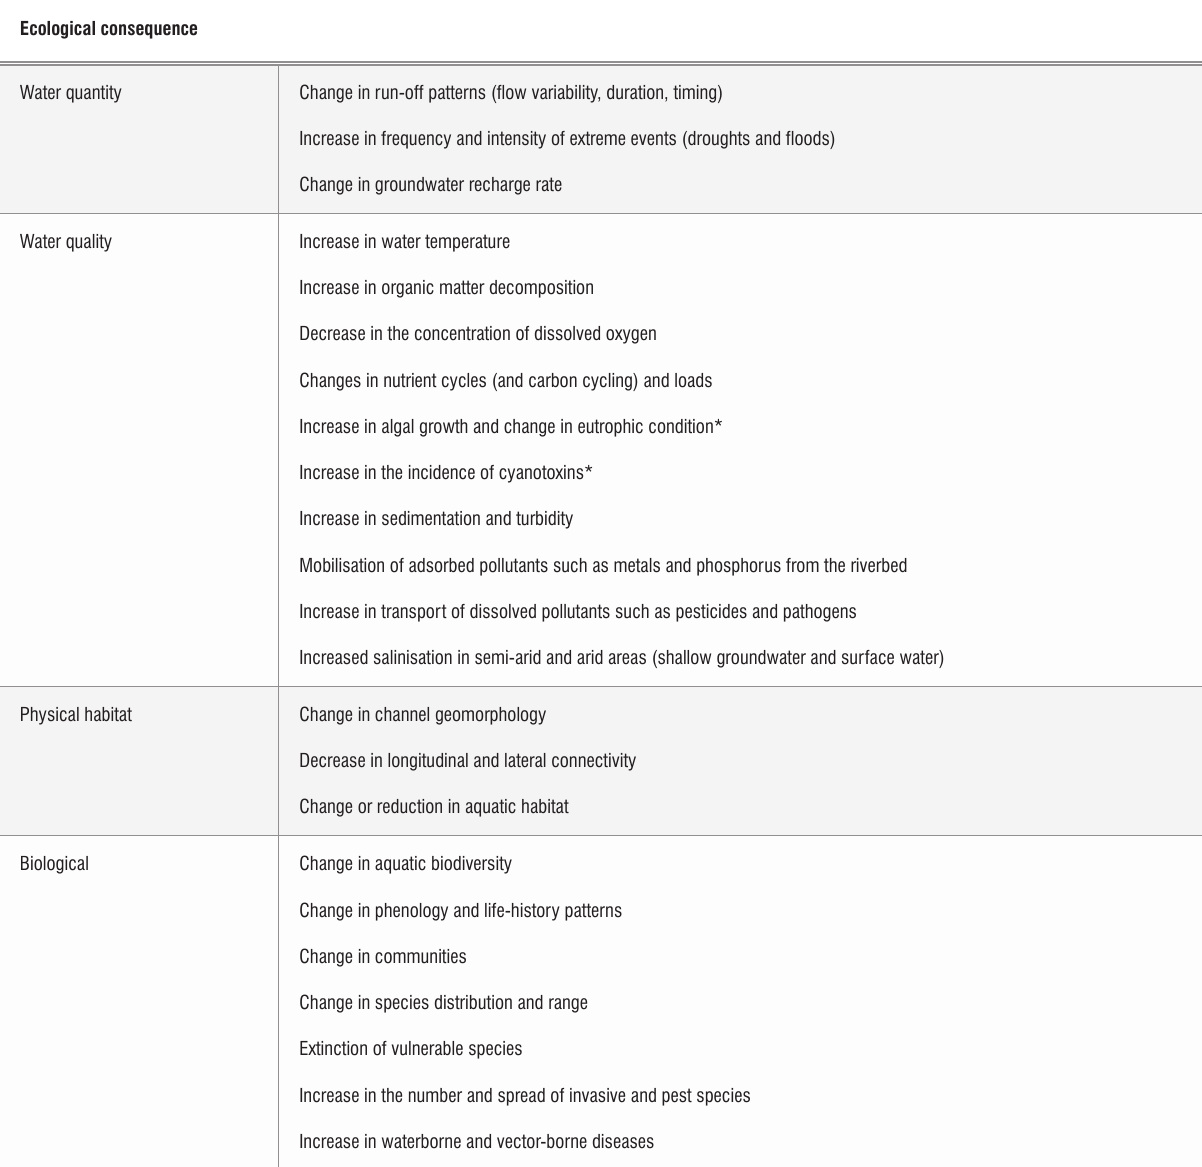
Global climate change drivers and ecological consequences of global climate change in freshwater ecosystems.